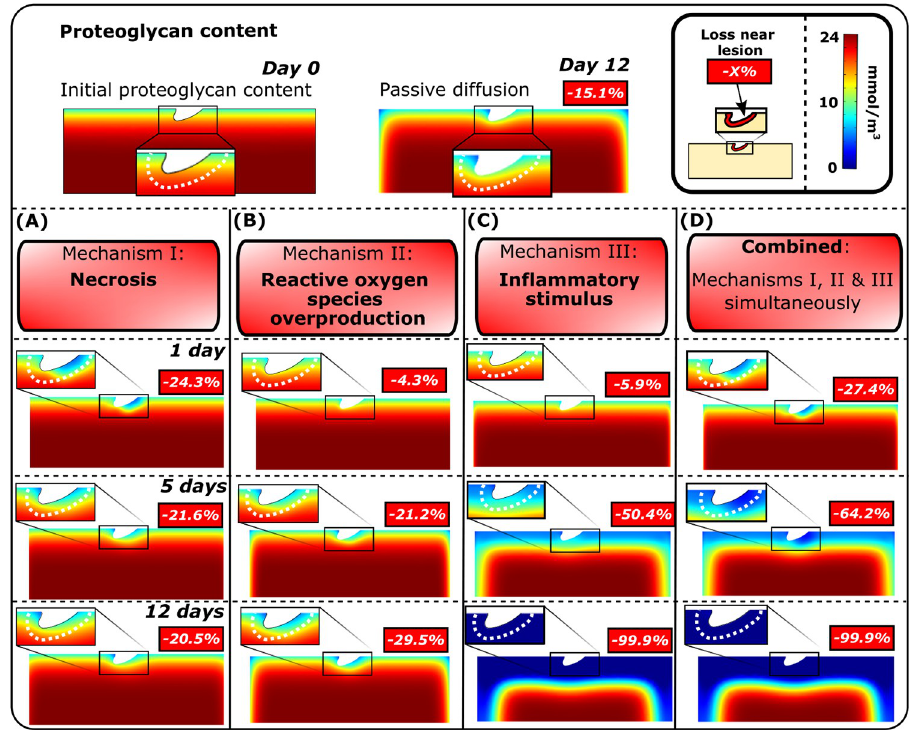
Fig 3. Simulated proteoglycan degeneration. Comparison of the simulated spatial changes in proteoglycan (PG) content after A) acute necrosis, B) cell damage, subsequent overproduction of reactive oxygen species and apoptosis, C) inflammatory stimulus, and D) combined mechanisms I, II, and III at days 1, 5, and 12 showed different temporal changes in PG distribution. Percentual changes in the proximity of the simulated lesion (0.1 mm from the lesion edge) were computed relative to the PG content at day